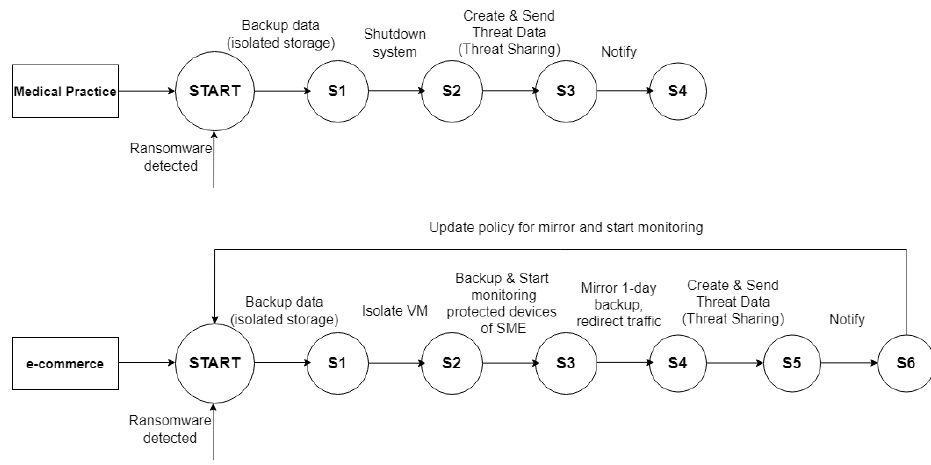
Figure 5. Examples of a personalised policy presented as